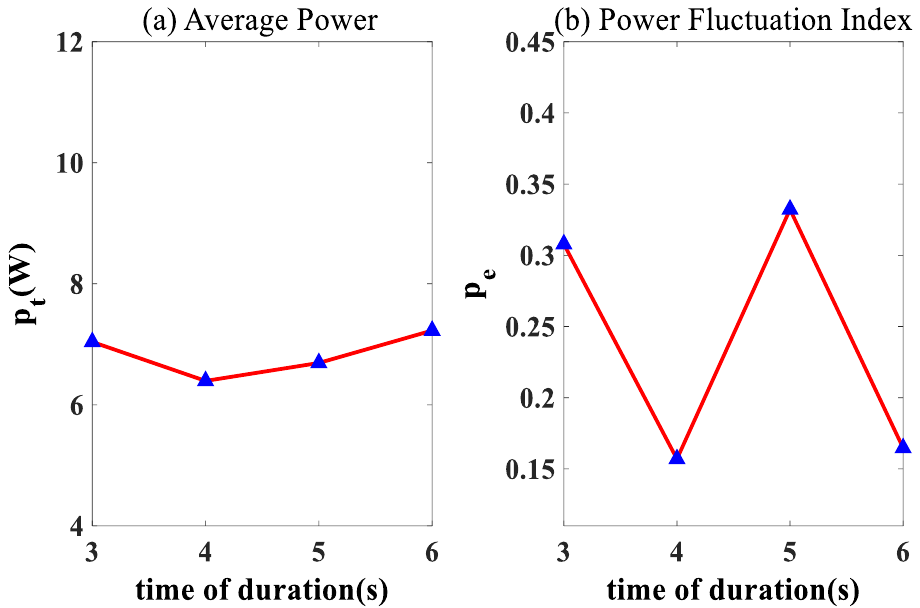
Figure 15. The average output power and power fluctuation index under different open state durations (trigger pressure is 3.5 MPa).